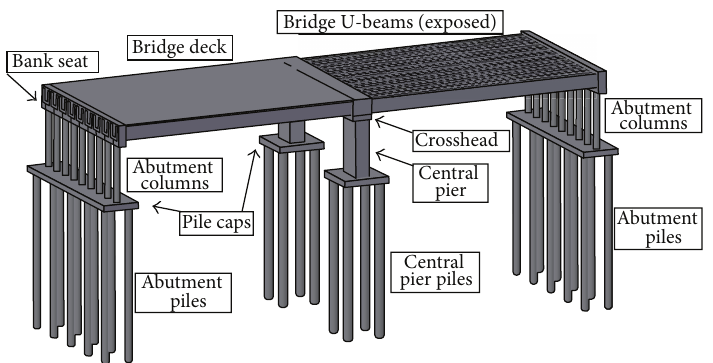
Figure 2: 3D rendering showing typical structural arrangement of a two-span integral bridge with flexible abutment supports.